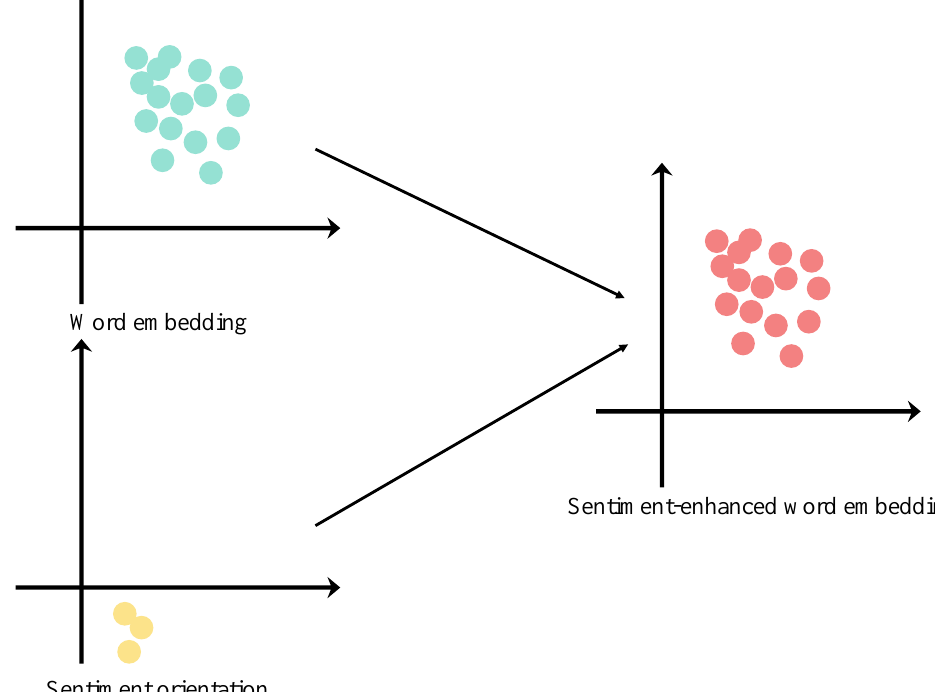
Figure 1. Intuitiveillustration of a sentiment-enhanced word embedding. Vectors with different colors represent that they belong to different vector